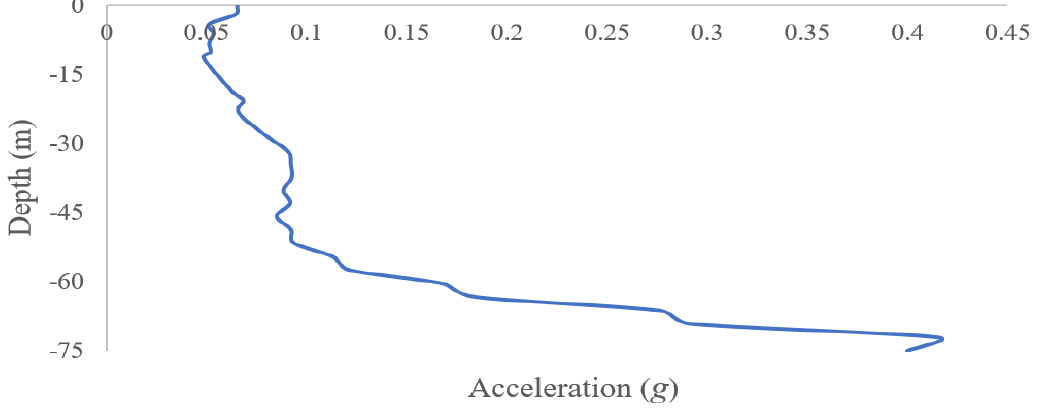
Figure 10. Maximum acceleration response with depth.